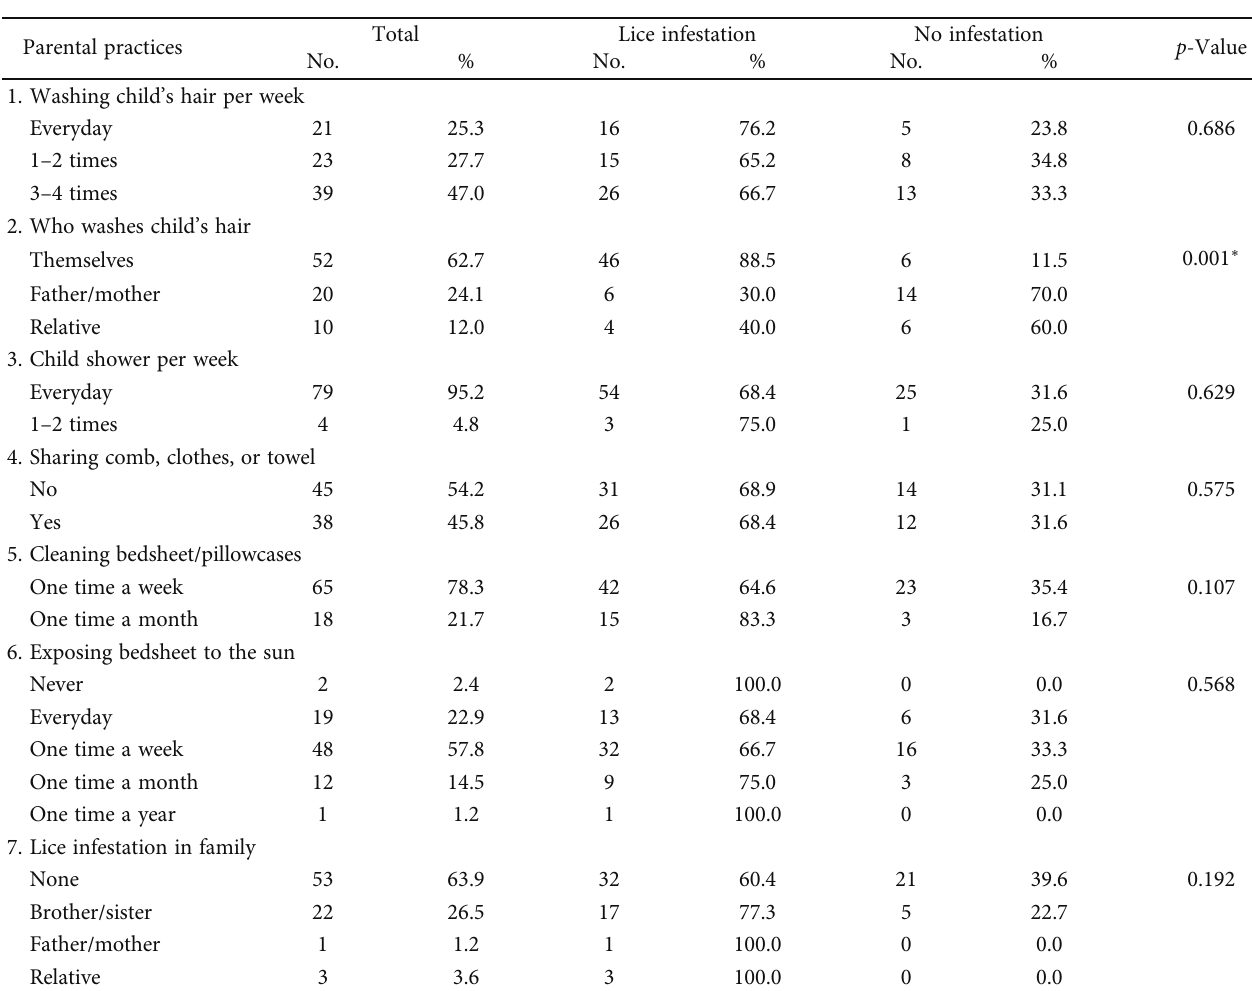
Table 5: Parental practices concerning head lice infestation and percentage of their children infested in a school in Lak Hok subdistrict. Parental practices